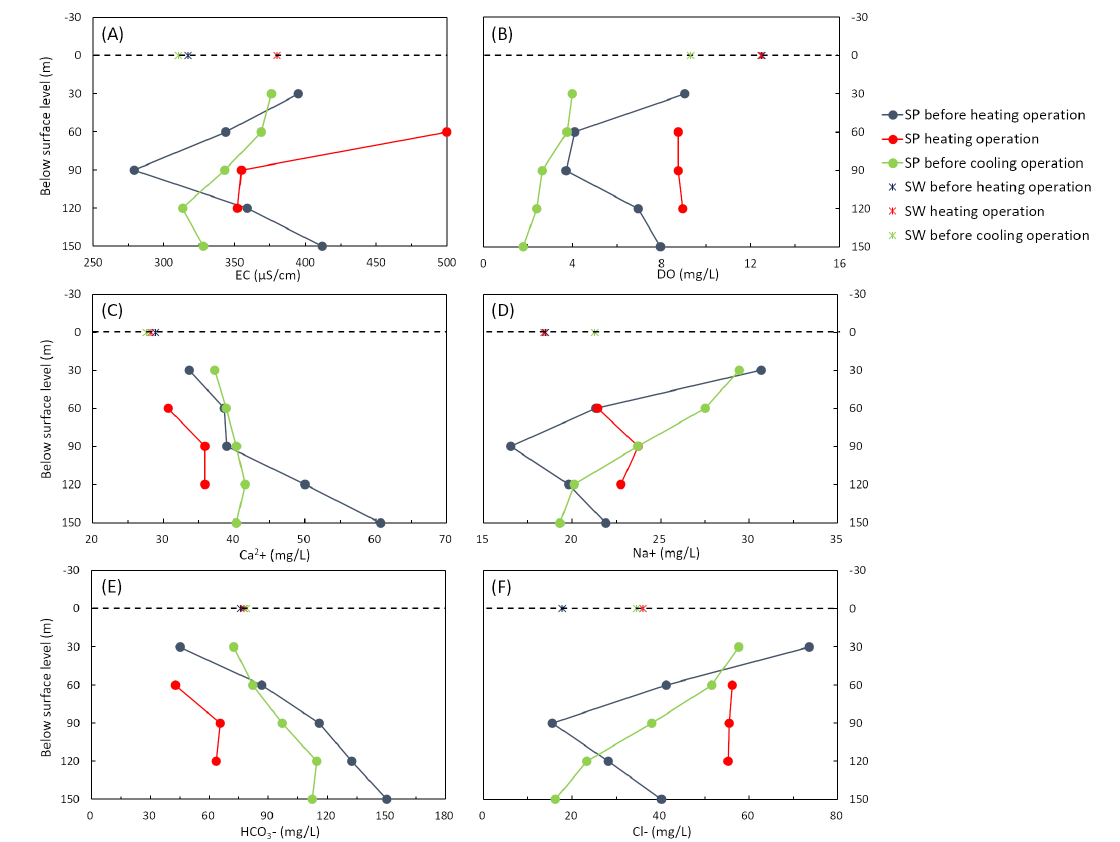
Figure 4. Vertical distributions of EC ( A ), DO ( B ), Ca 2 + ( C ), Na + ( D ), HCO − and SW